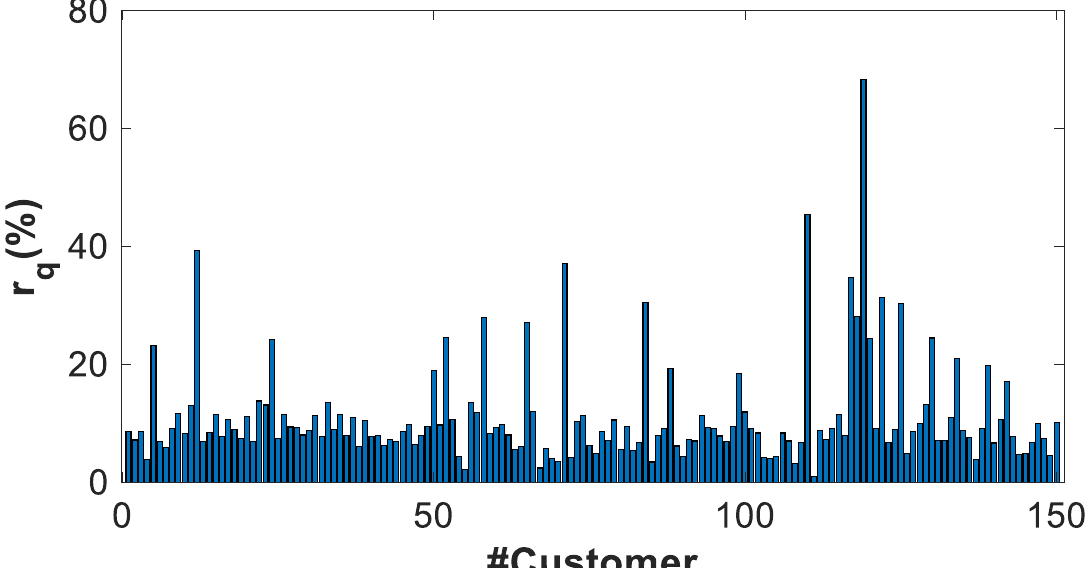
Figure 12. The partial residual of the power profiles estimator, 𝑌̂ , obtained using the reference algorithm without the clustering phase. The residual is normalized by the upper bound of the contractual power of the subset of considered power profiles (i.e., P = 16.5 kW).